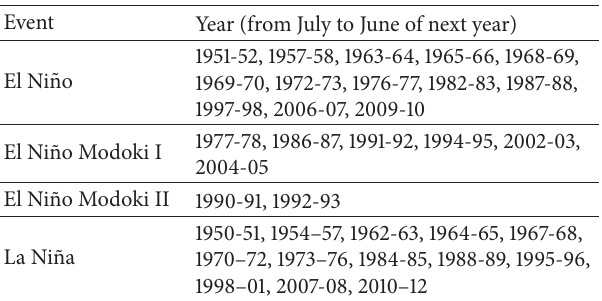
Table 1: The years of El Ni˜no, El Ni˜no Modoki I, El Ni˜no Modoki II, and La Ni˜na events from 1950 to